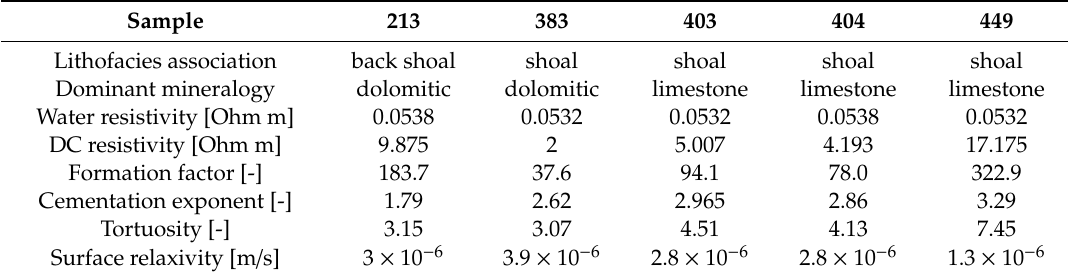
Table 4. Resistivity and NMR derived sample